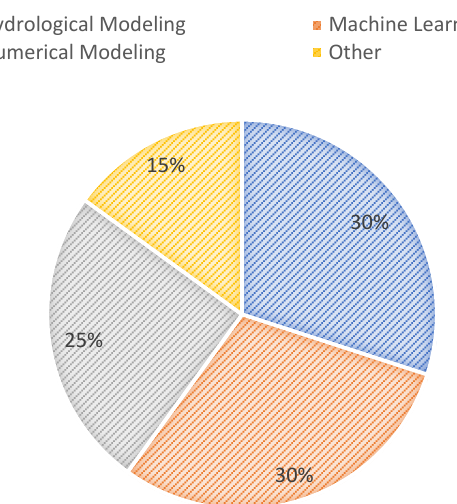
Figure 5. Methods adopted in studies .